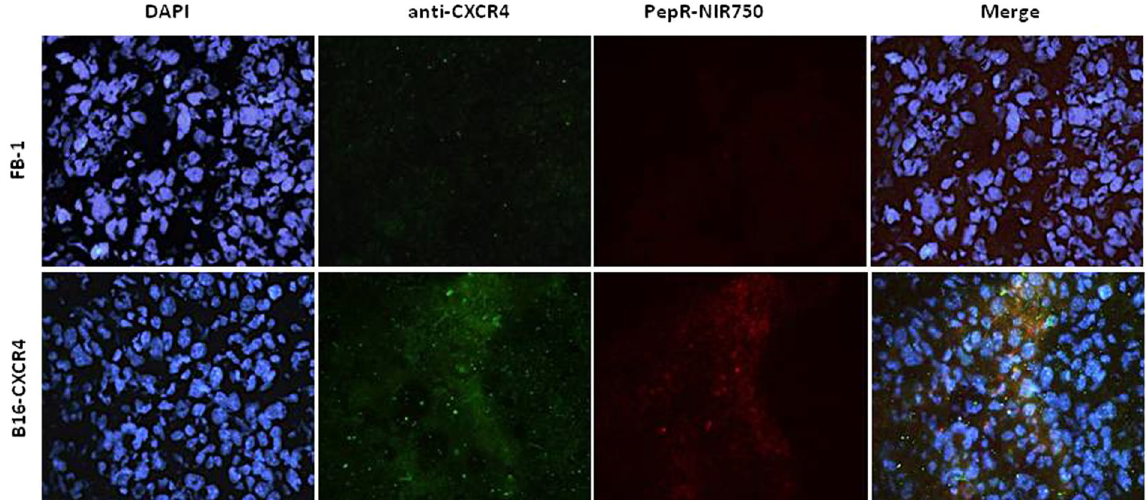
Figure 2. In vivo evaluation of PepR-NIR750 binding to CXCR4 expressing subcutaneous tumors. B16-CXCR4 and FB-1 subcutaneous tumors in CD-1 nu/nu athymic mice were i . v . injected with PepR-NIR750 (red) and examined with a fluorescent CXCR4 antibody (green) and imaged at fluorescence microscope Axioscope A.1. Nuclei were stained with DAPI. Merged images of anti-CXCR4 antibody staining and PepR-NIR750 fluorescence are shown in the last panel. PepR-NIR750 binds to B16-CXCR4 cells but not to FB-1 cells.